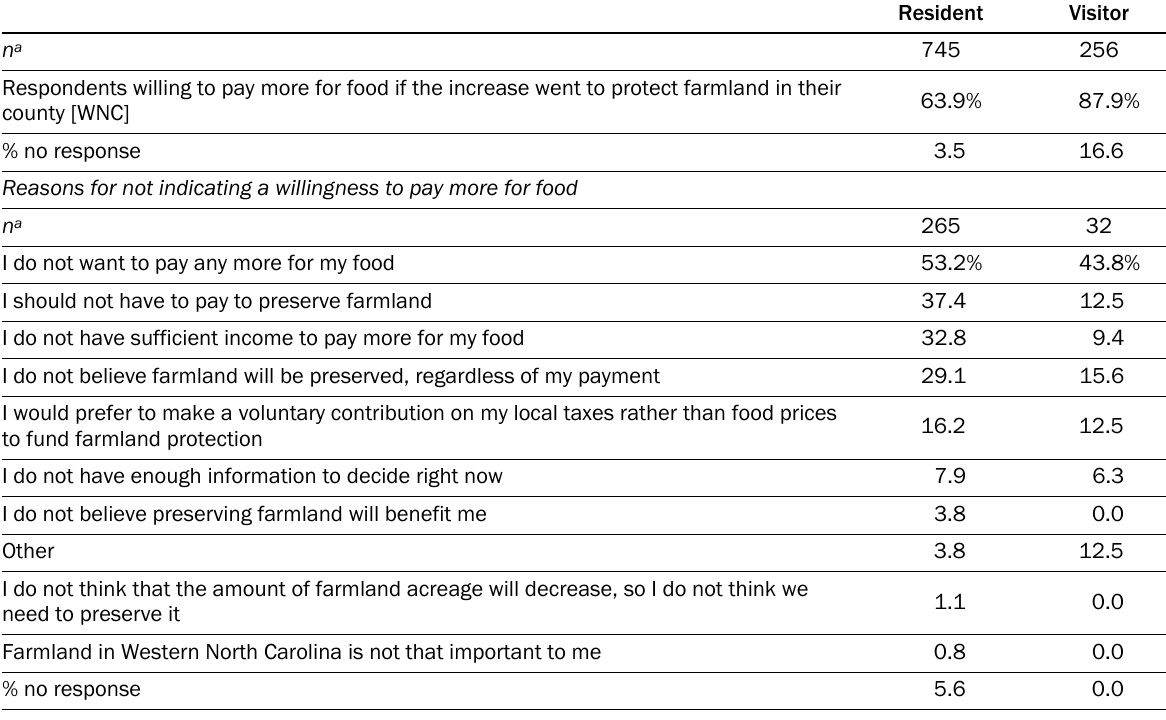
Table 10. Willingness to Pay More for Food and Reasons for Not Doing